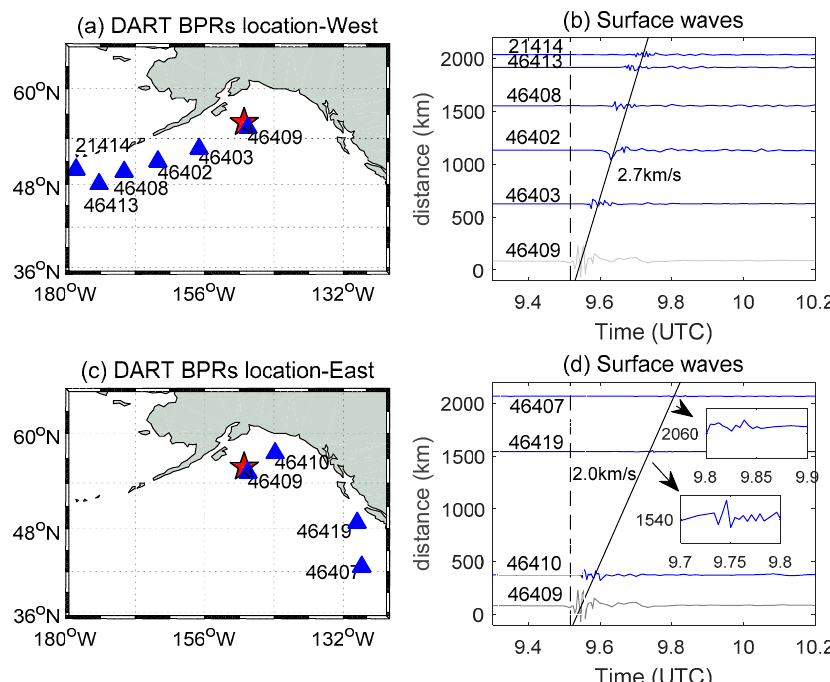
Figure 7. The sea level change in the vicinity of the epicenter recorded by Bottom Pressure Records (BPRs). The location of the site is shown in ( a , c ). The sub-graphs in the ( d ) are the enlarged views of station 46419 and 46407.